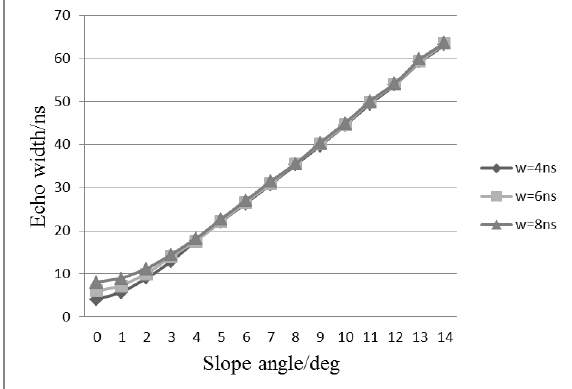
Figure 8. The change of waveform size in different